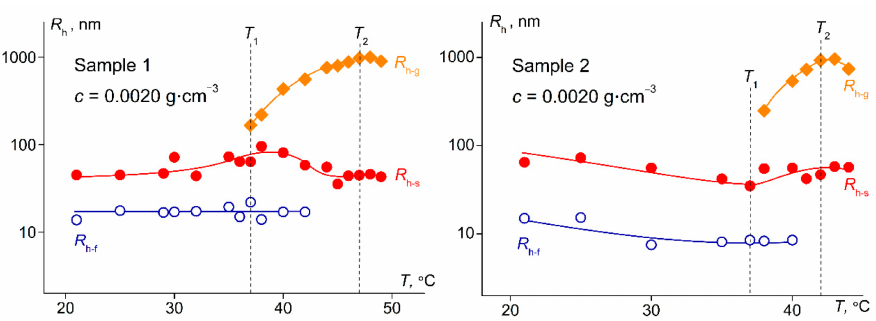
Figure 8. Temperature dependences of hydrodynamic radii R h of scattering objects for aqueous solutions of PDMS- g